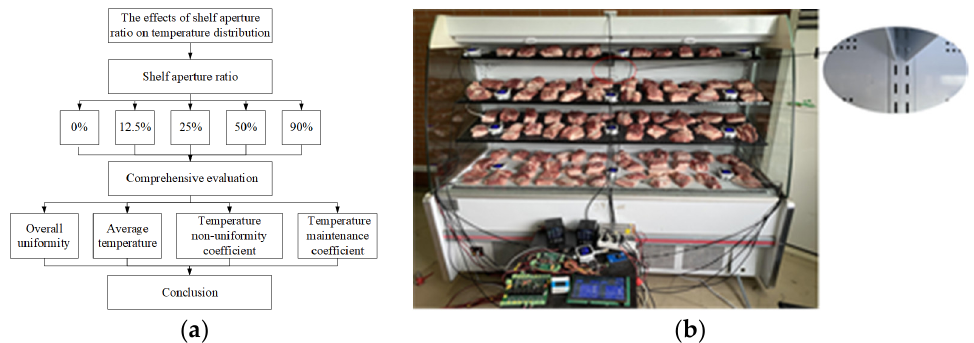
Figure 2. Test methods and equipment. ( a ) The research route; ( b ) photograph of the setup for the pork cold storage test. pork cold storage